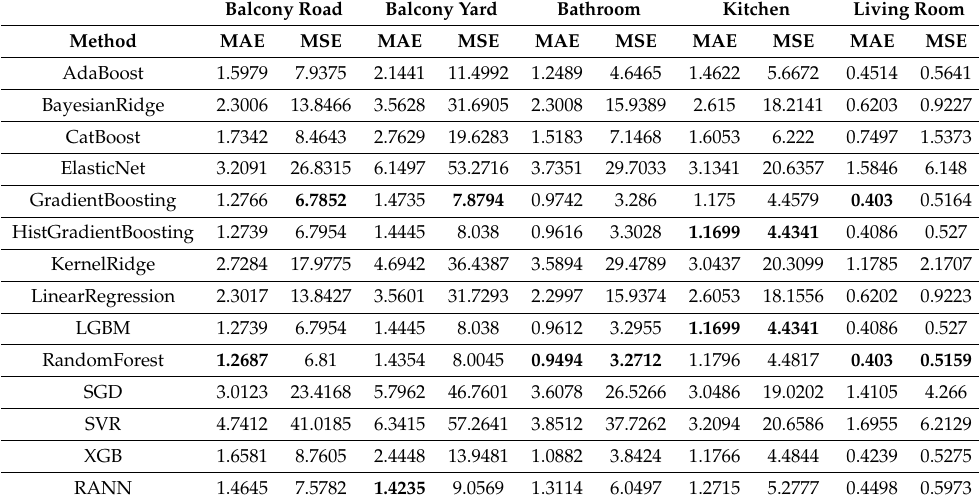
Table 1. Evaluation of algorithms for every